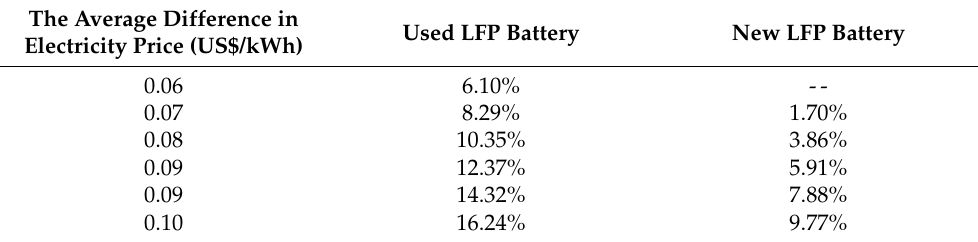
Table 11. ROI on LFP lithium-ion batteries. Source: [33]. The Average Difference in Electricity Price